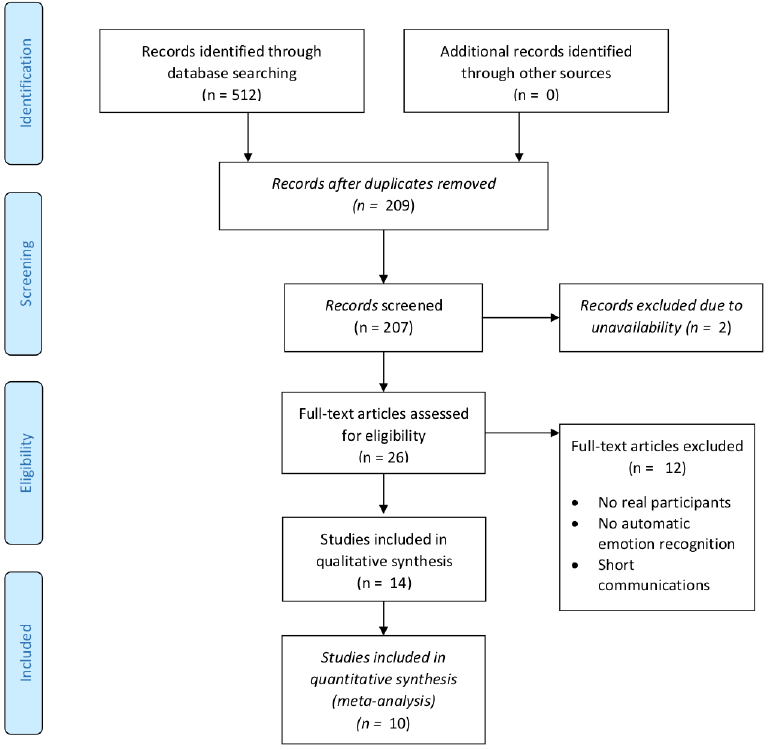
Figure 2. PRISMA flow diagram for the systematic review of the automatic recognition of emotions of children with autism in January